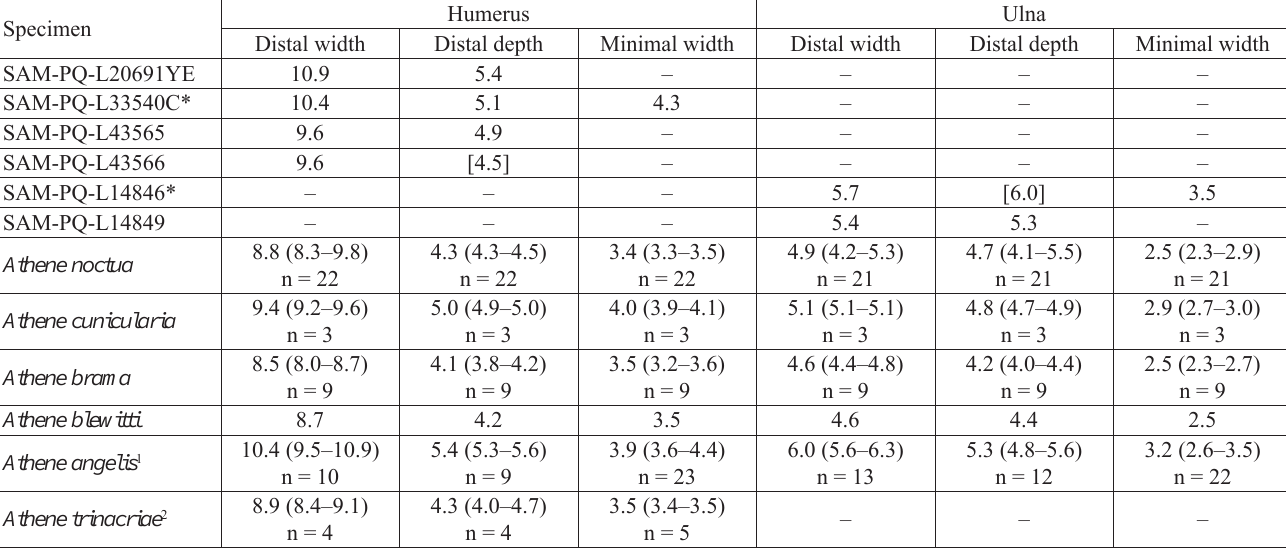
5. Measurements (in mm) of humerus and ulna of Athene inexpectata sp. nov. from Langebaanweg compared with the corresponding bones of extant and fossil Athene species. Measurements of slightly worn or damaged bones are given in square brackets. Paratypes are indicated by an asterisk; 1 measurements after Mourer-Chauviré et al. (1997); 2 measurements after Pavia and Mourer-Chauviré (2002); n, sample